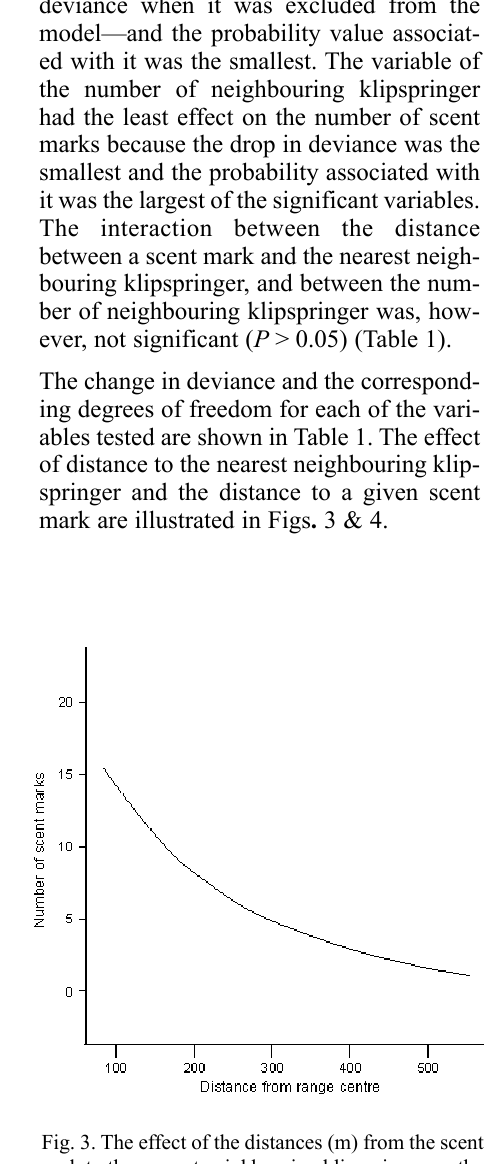
Fig. 3. The effect of the distances (m) from the scent mark to the nearest neighbouring klipspringer on the number of scent marks produced by the klipspringer group studied in the Kruger National Park as obtained from log–linear regression techniques.